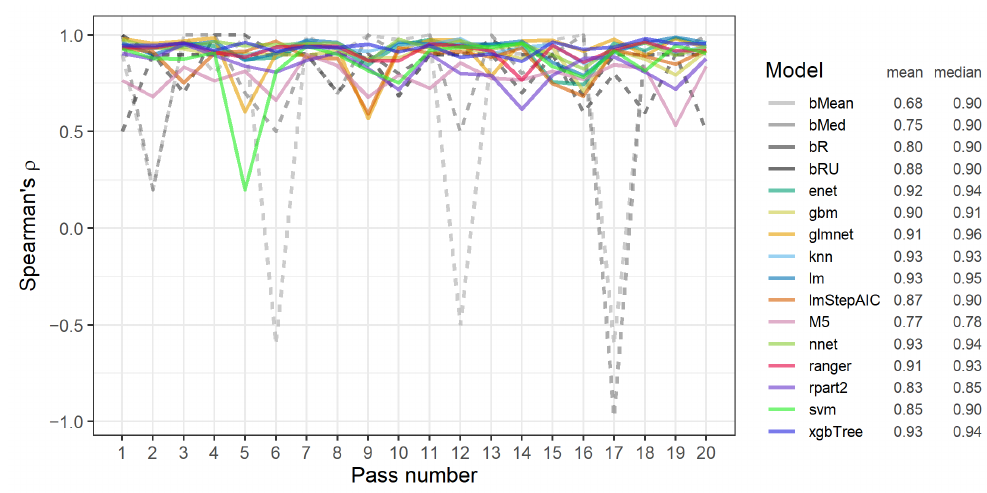
Figure 7. Spearman’s ρ for MAE between CV and test subsets for each model and pass across all data variants. The values in braces denote the mean and median values of ρ for each model across all